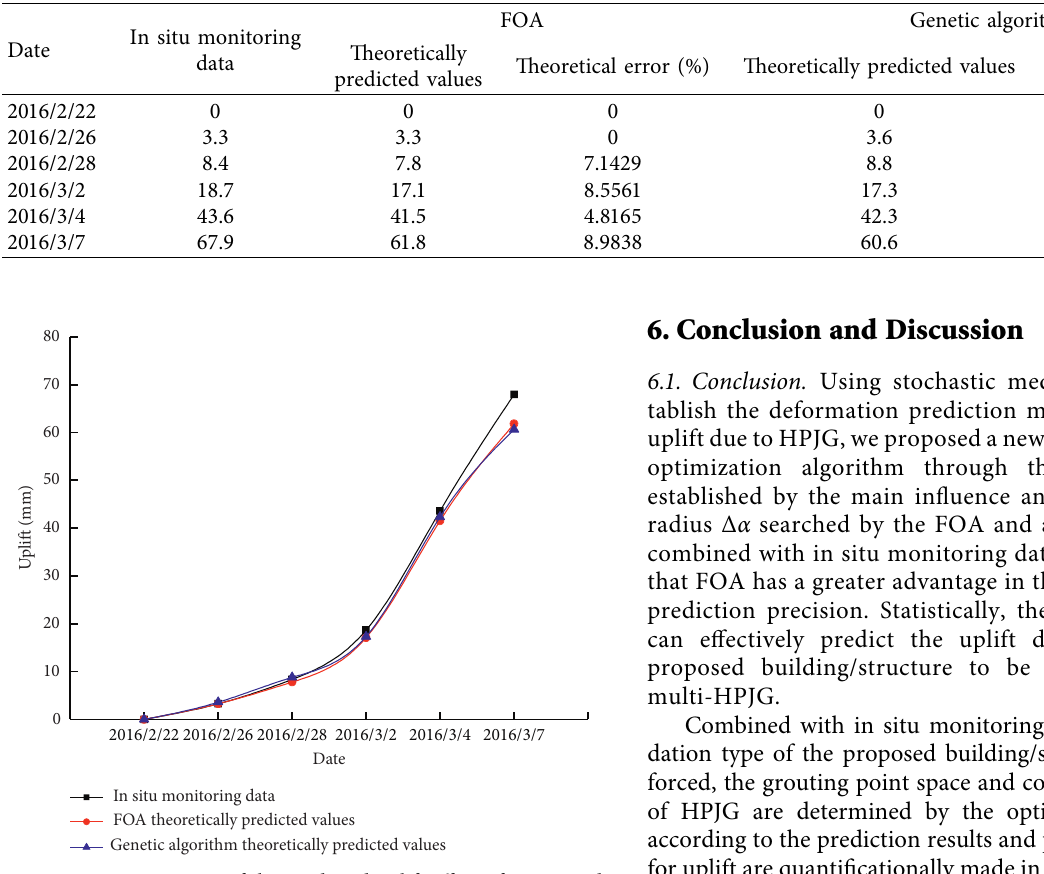
Table 4: Optimized FOA results.